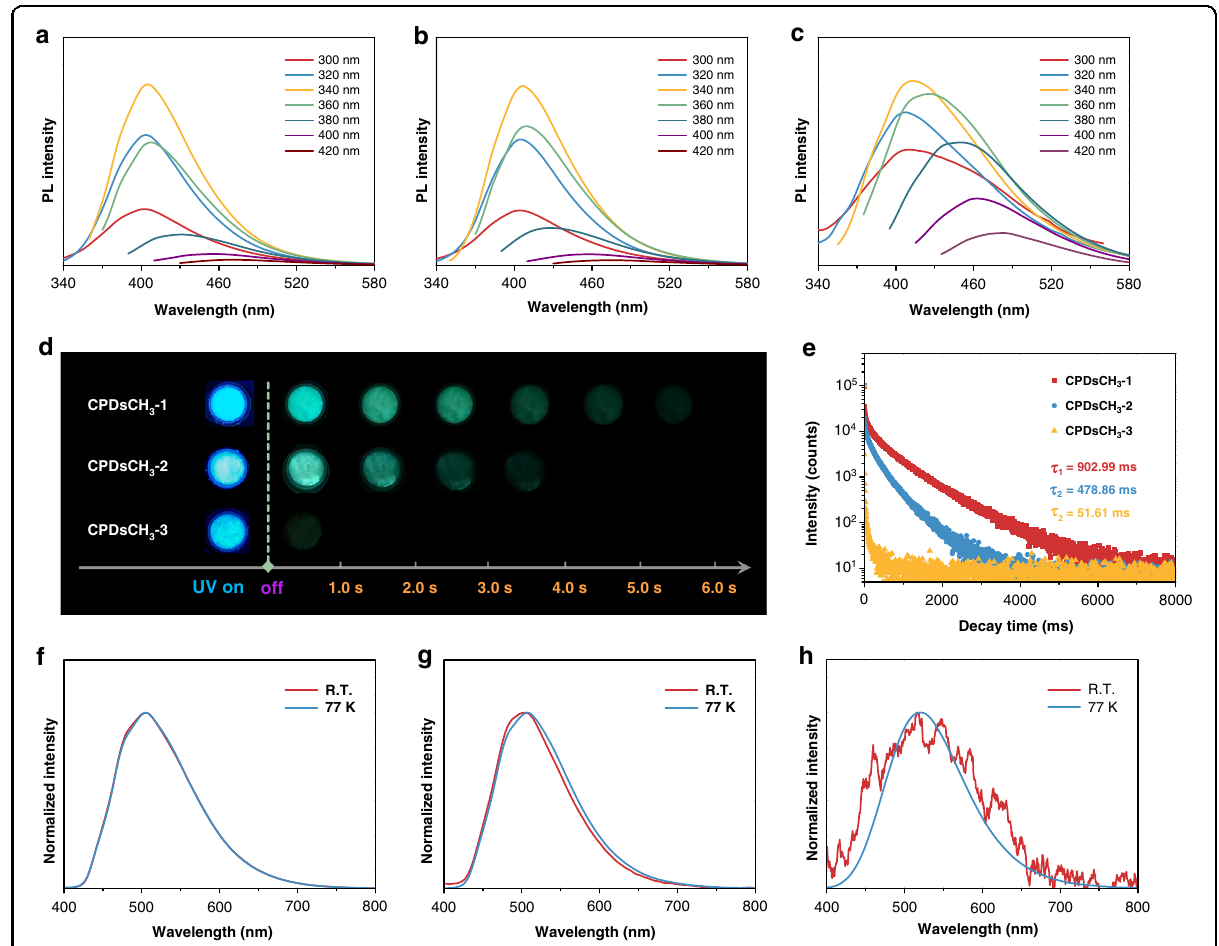
Fig. 2 Luminescent properties of CPDs. PL spectra recorded with solution-state a CPDsCH 3 -1, b CPDsCH 3 -2, and c CPDsCH 3 -3. d Images corresponding to the delay time recorded post UV irradiation. e RTP decay spectral pro fi les. Normalized afterglow spectra of f CPDsCH 3 -1, g CPDsCH 3 -2, and h CPDsCH 3 -3 at room temperature (R.T.) and 77